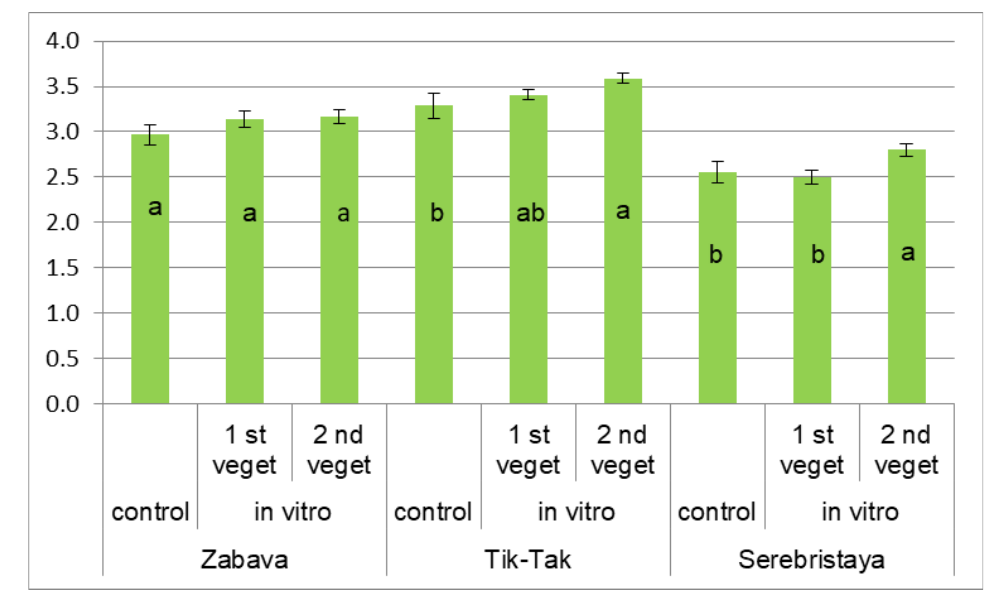
Figure 2. The content of EO in the aerial part of peppermint plant, depending on the growing conditions, %. For each chemotype, columns followed by the same letter are not significantly different according Tukey’s test ( p ≤ 0.05); bars represent standard deviations. 1st vegetation year—2020; 2nd vegetation year—2021.